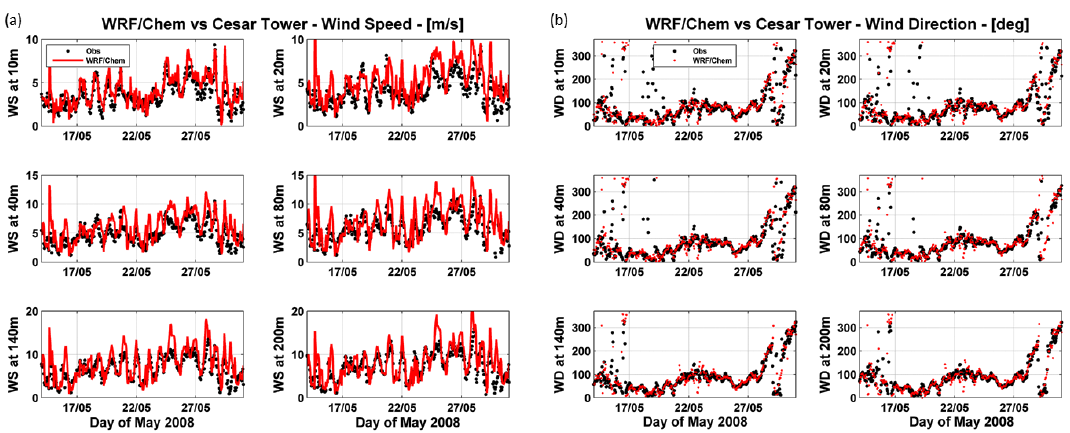
Figure 3. Observed (black lines) at Cesar tower and simulated (red lines) time series of wind speed (a) and wind direction (b) at different